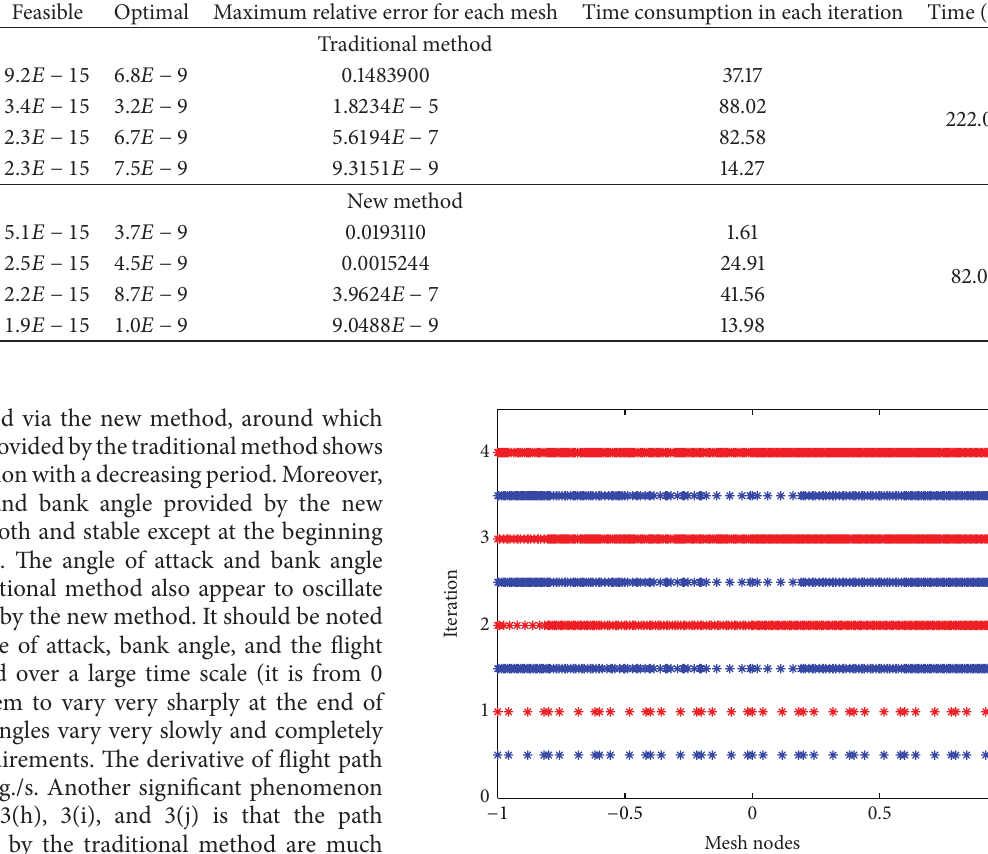
Table 2: Optimal result by SNOPT.